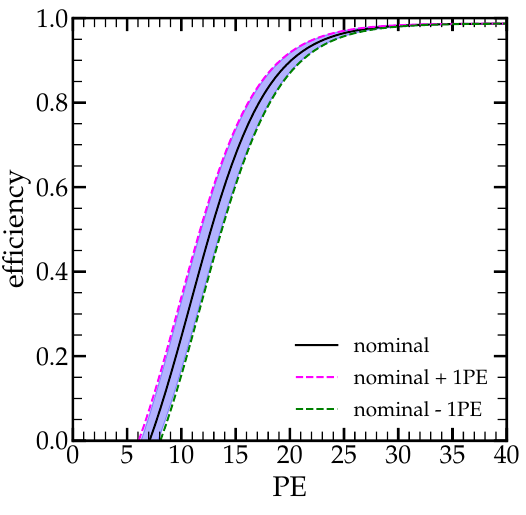
Figure 16 . COHERENT-CsI efficiency as a function of PE along with its 1 σ